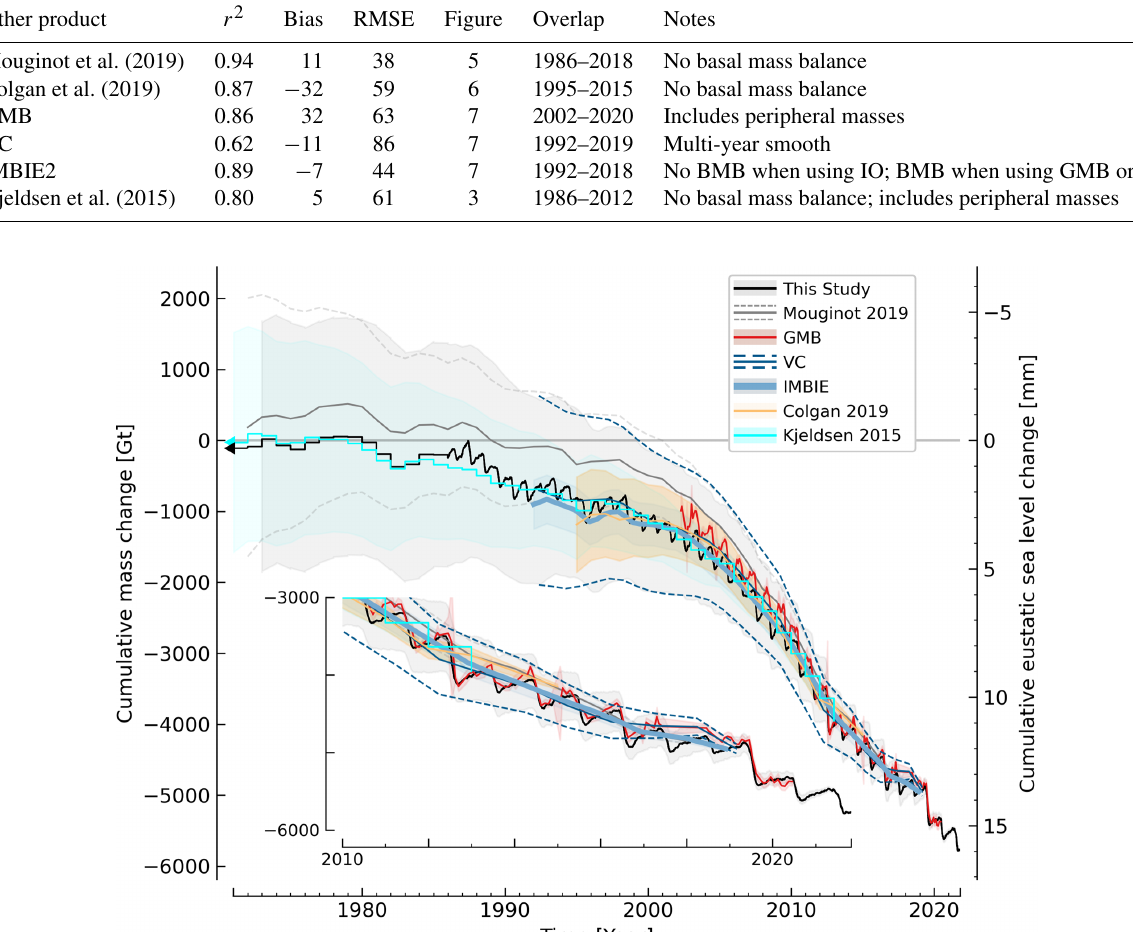
Table 2. Summary of correlation, bias, and RMSE between different products during their overlap periods with This Study. Basal mass balance not included in This Study when comparing against Mouginot and Rignot (2019), Colgan et al. (2019), or Kjeldsen et al. (2015). Peripheral ice masses never included in This Study. Figure